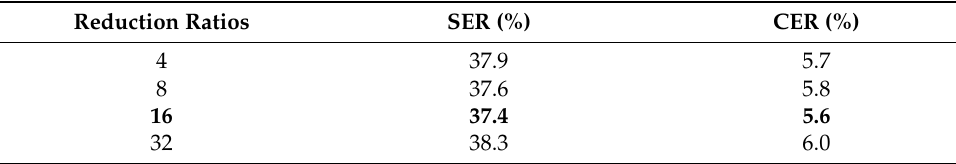
Table 5. Different reduction ratios of SE-Conformer settings.